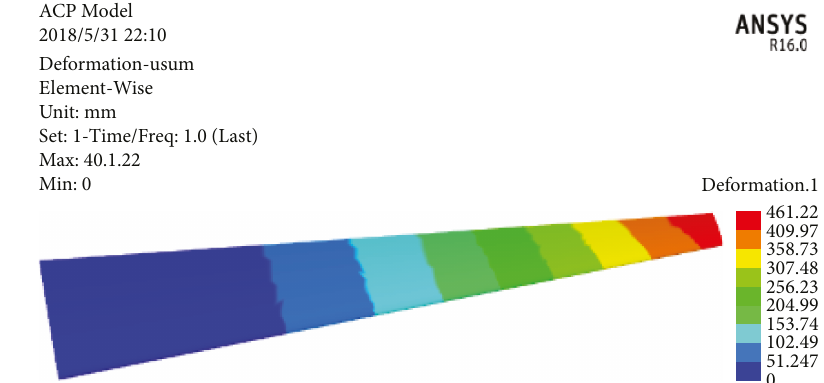
Figure 14: Deformation cloud diagram with the layer sequence being [0/45/90/-45/0]